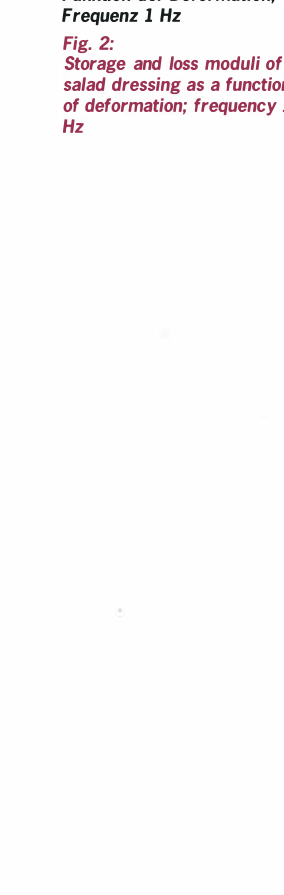
Fig. 2: Storage and loss moduli of